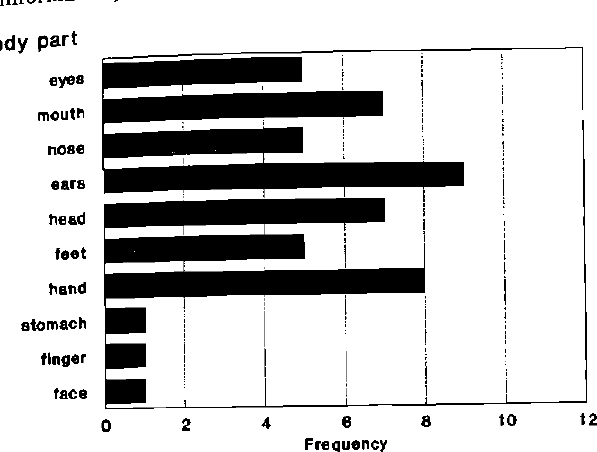
Figure 1: Frequency of correct identification of body parts Children's ability to identify their body parts was also assessed in the tester-child interaction, in which it was found that ten of the subjects (40%) did not respond to this task while nine subjects (36%) could identify body parts such as izin- dlebe 'ears' and umlomo 'mouth' and six subjects (24%) could